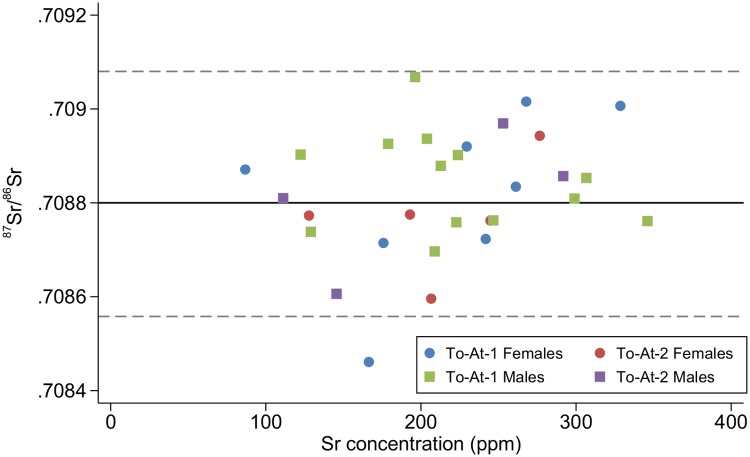

87Sr/86Sr values plotted by sex and burial mound.Population mean (solid line) and ± 2SD (dashed line) represented.